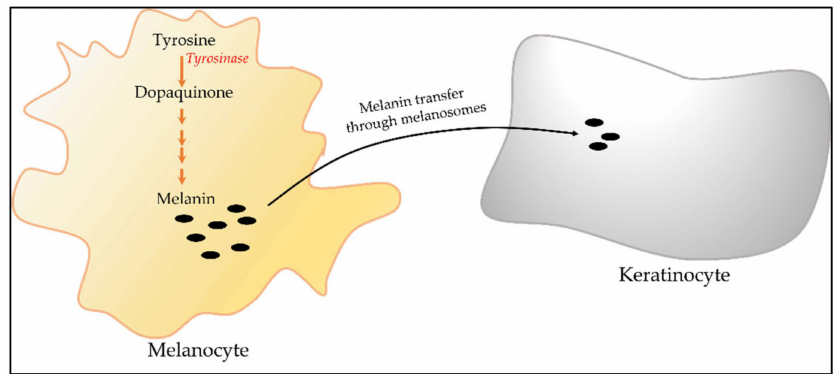
Figure 5. Schematic of melanin biosynthesis. Melanin biosynthesis takes place in melanocytes using tyrosine. Tyrosinase is a key enzyme for the synthesis of melanin. Once produced, melanin is trans- ported to keratinocytes. Inhibition of tyrosinase, inhibition of melanogenesis, and melanin transfer are the main functions considered when screening cosmetic ingredients for their anti-hyperpigmentation